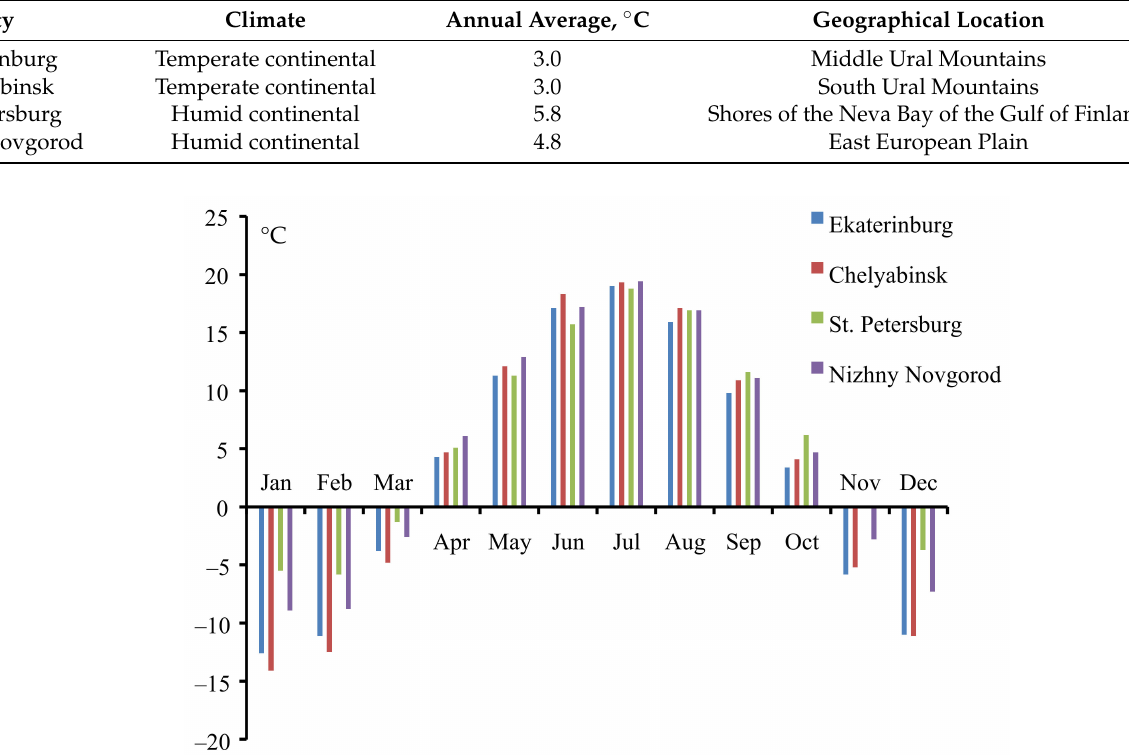
Figure 2. Average monthly temperatures based on long-term (1981–2010) observations of studied cities (http://www.pogodaiklimat.ru/, accessed on 10 June